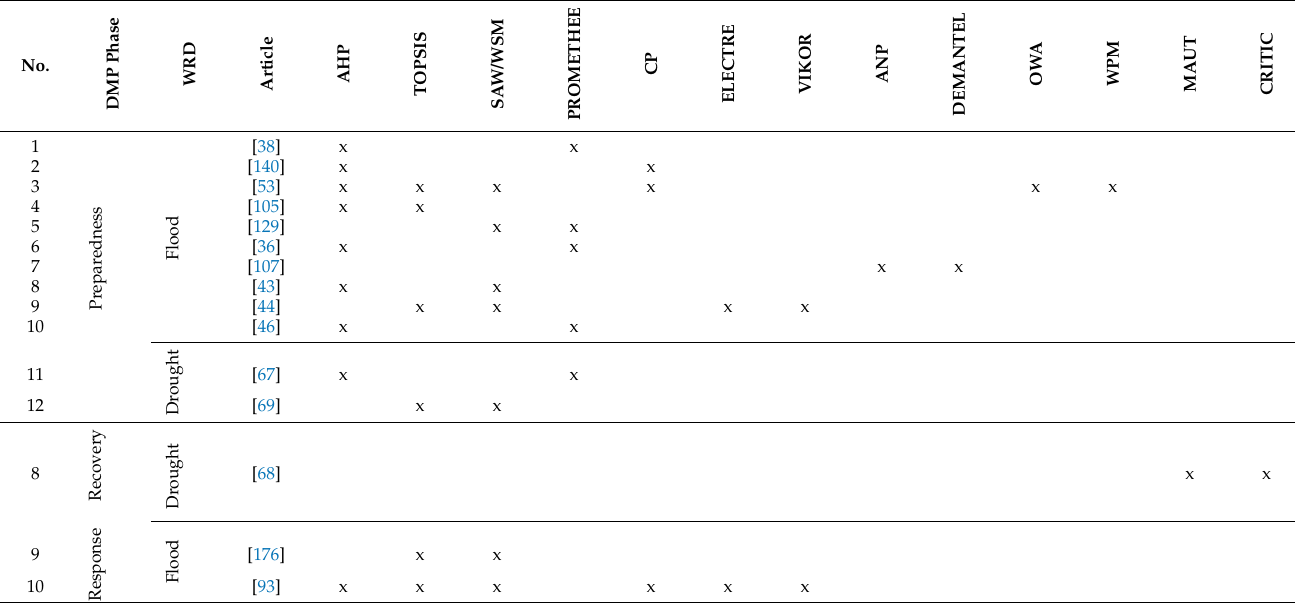
Table 12. Application of mixed-method techniques for preparedness, recovery, and response